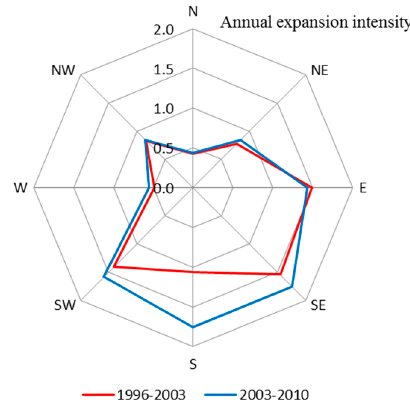
Figure 11. Annual expansion intensity in Beijing. Three color arrows were used for the visualization between the Beijing municipal government and the urban expansion direction of districts and counties. The red arrow represents the direction of expansion in the map and points to the city center, a green arrow represents deviation from the city center, and black arrows represent other